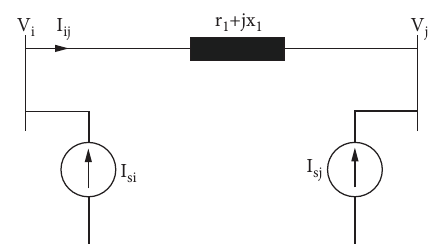
Figure 8: Te model of fow injection for TCSC.